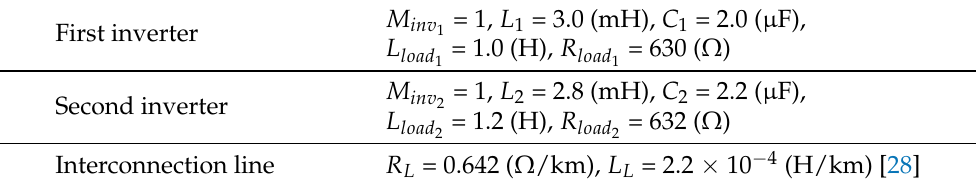
Table 1. The values of the system parameters used in